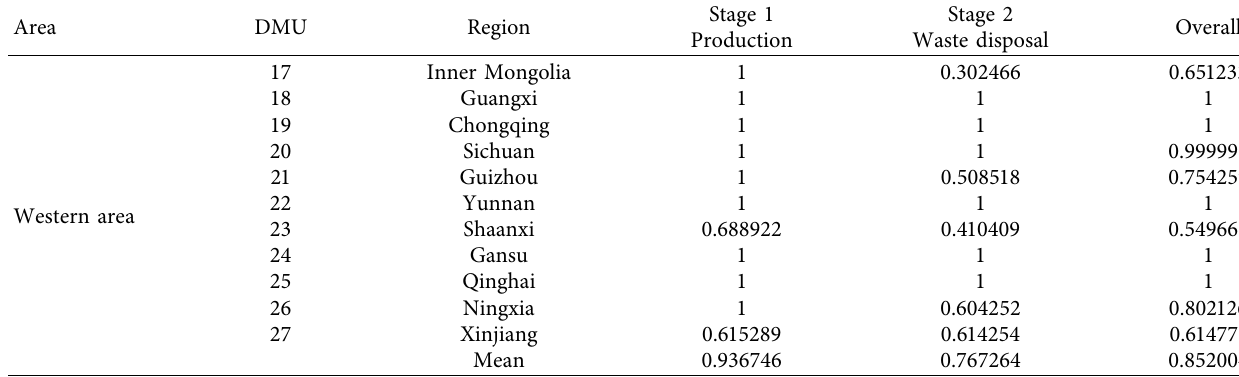
Table 8: Area-wise efficiency evaluation results in the Western area.